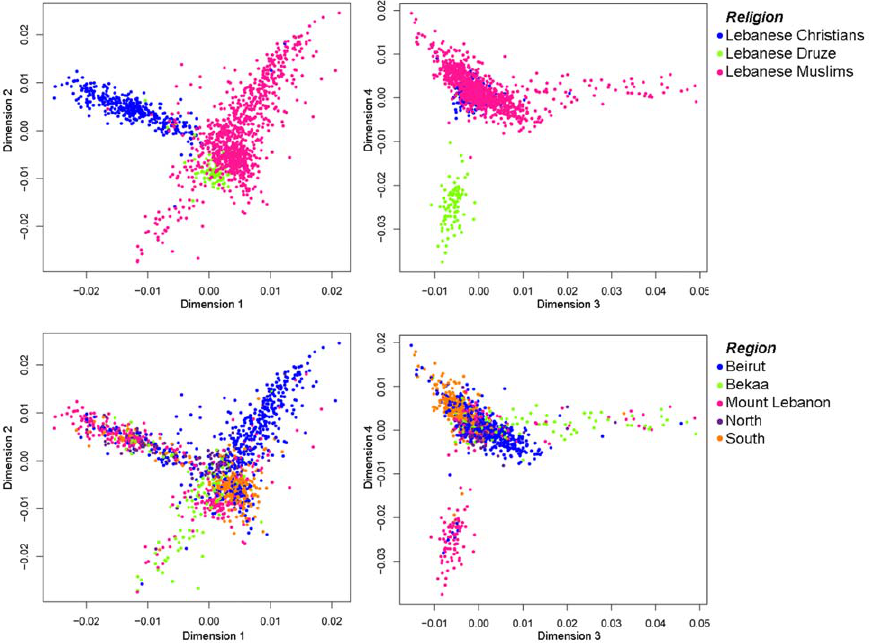
Figure 1. Multidimensional scaling of . 240K SNPs in 1,341 Lebanese samples showing the first four dimensions. The SNPs were pruned from . 500,000 SNPs excluding r 2 . 0.4. The samples were classified by their religion or region of origin.